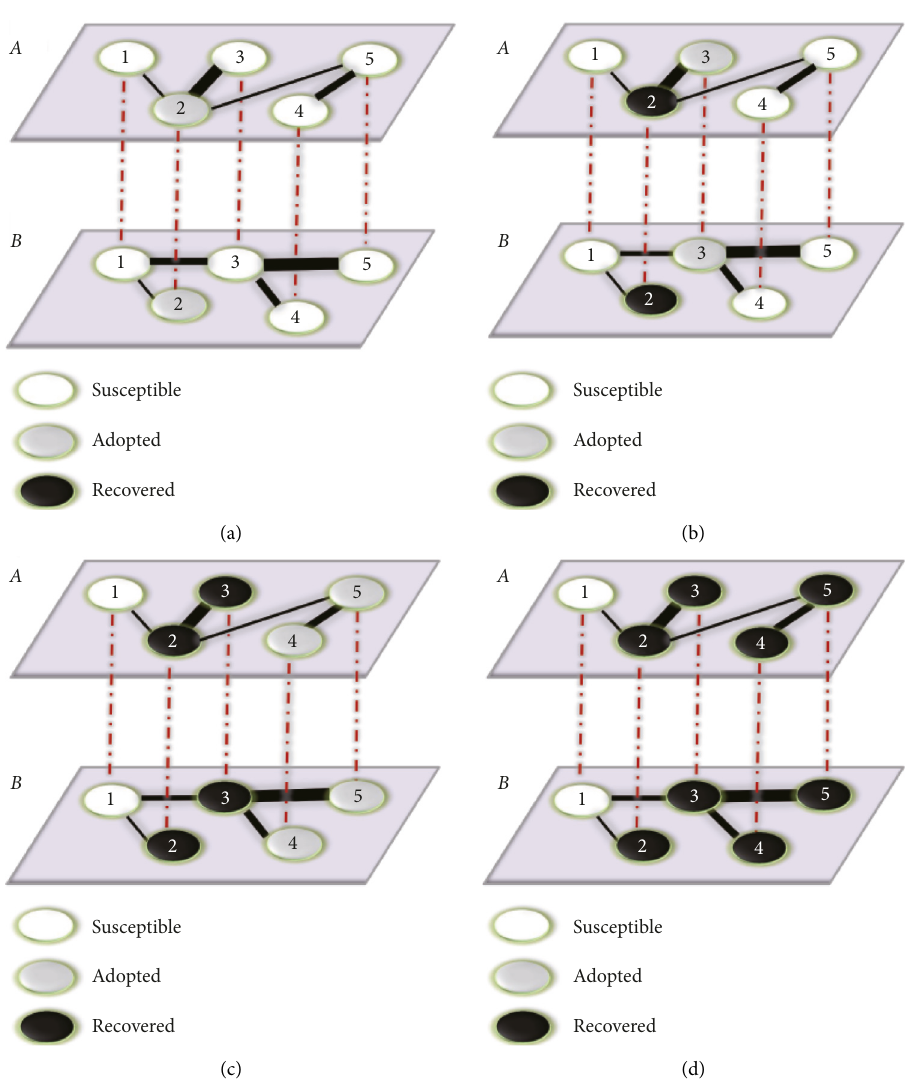
Figure 1: Illustration of social information spreading with transformation of three states (susceptible, adopted, and recovered) on a weighted multiplex network. Two different independent social networks A and B , comprising degrees of intimate relations, represent two layers of the weighted multiplex network, in which different degrees of edge-widths denote different